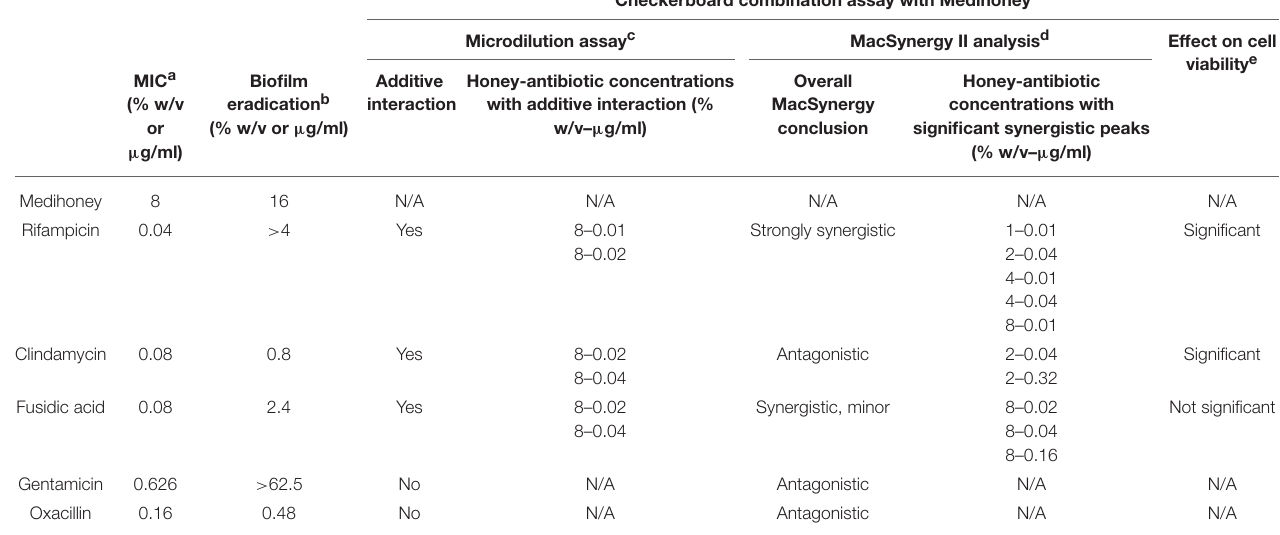
TABLE 1 | Summary of the results of Medihoney and antibiotic treatments on S. aureus